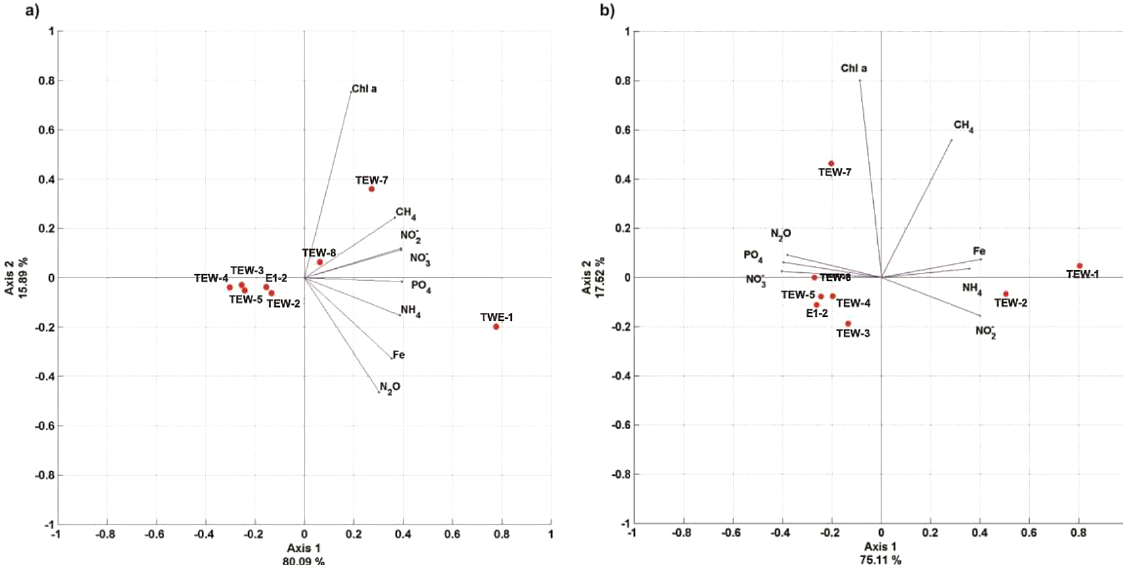
Figure 5. PCA with environmental data including dissolved iron obtained in the zonal transect (TEW). PCA comprises (a) data from the surface to the base of the ML and (b) environmental data from the surface to 500m depth. Stations along with the eigenvectors are